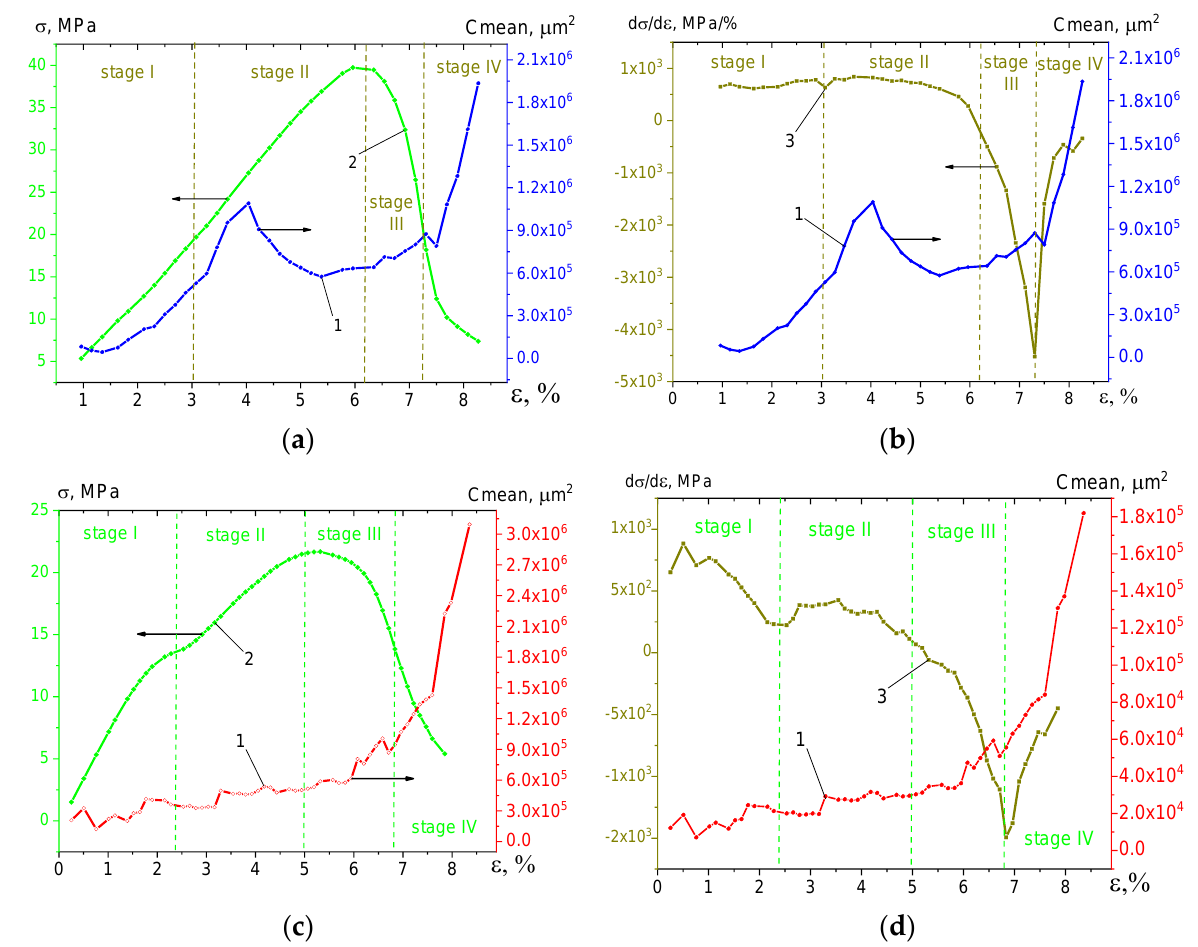
Figure 24. Strain-matched specific normalized circulation Cmean (1) with curves “σ - ε” (2) and “strain hardening - ε” (3) for Sample #1 ( a , b ) and for Sample #4 ( c , d ).